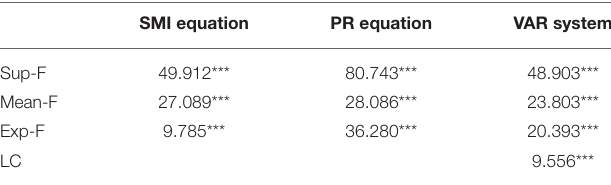
TABLE 3 | Parameter stability